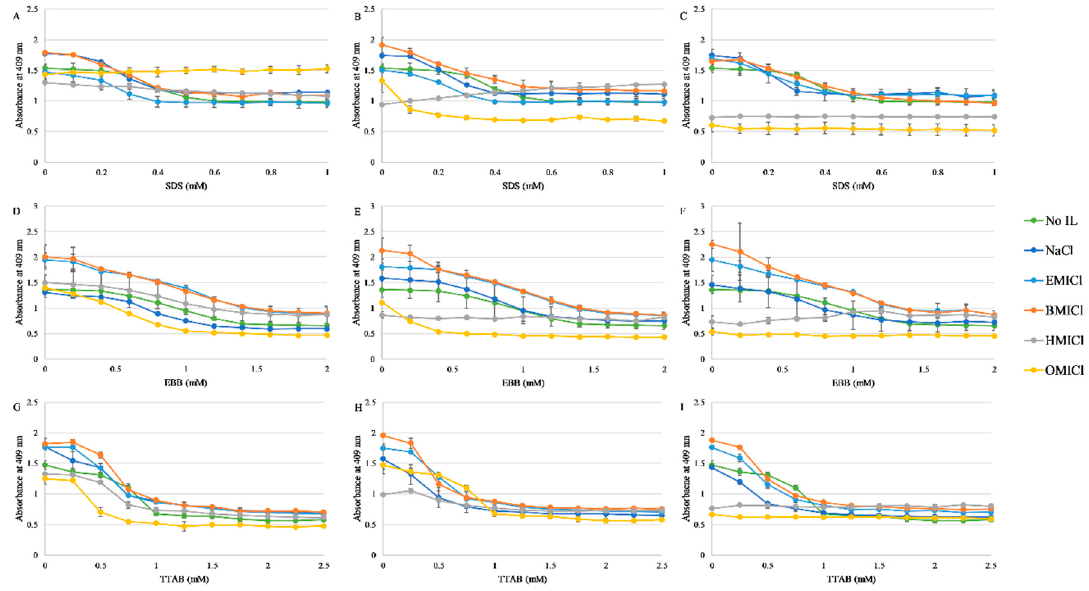
Figure 3. Dissociation of heme from myoglobin by absorbance spectroscopy. Color coding for each RTIL or control is indicated in the figure. Panels ( A – C ) are with SDS, ( D – F ) are with EBB, and ( G–I ) are with TTAB. Panels ( A ), ( D ), and ( G ) (left column) are supplemented with 50 mM of RTIL; panels ( B ), ( E ), and ( H ) are supplemented with 150 mM RTIL; panels ( C ), ( F ), and ( I ) are supplemented with 300 mM RTIL. Data represent the average of at least three replicates, error bars represent the standard deviation, and lines are not fits but are only to guide the eye.